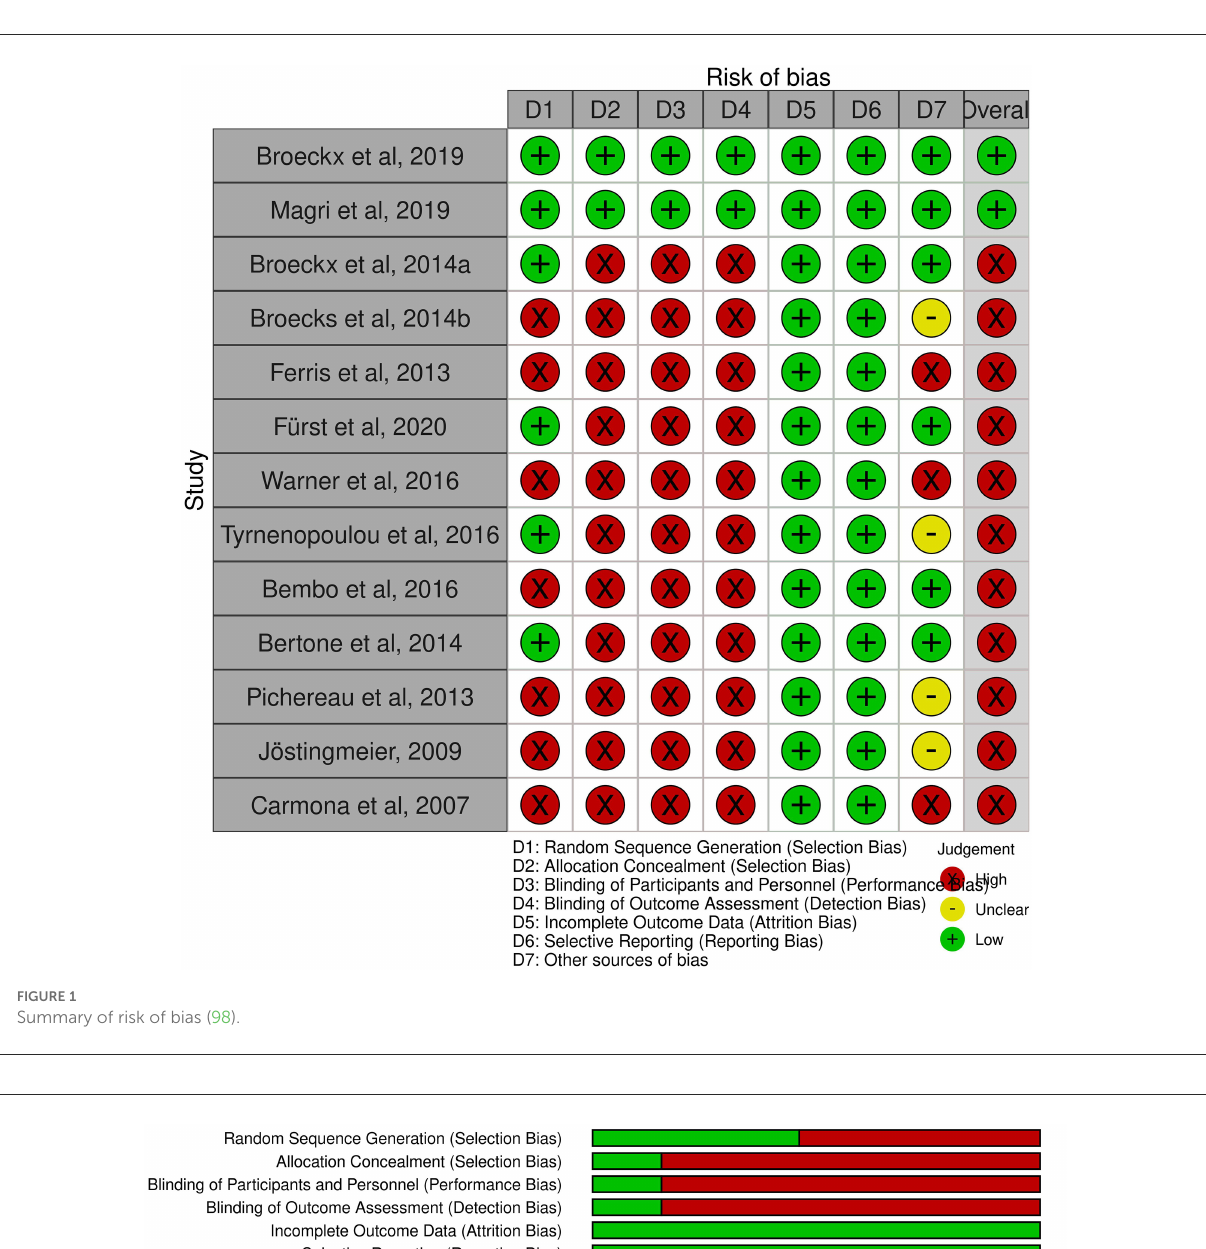
FIGURE2 Risk of bias (98).